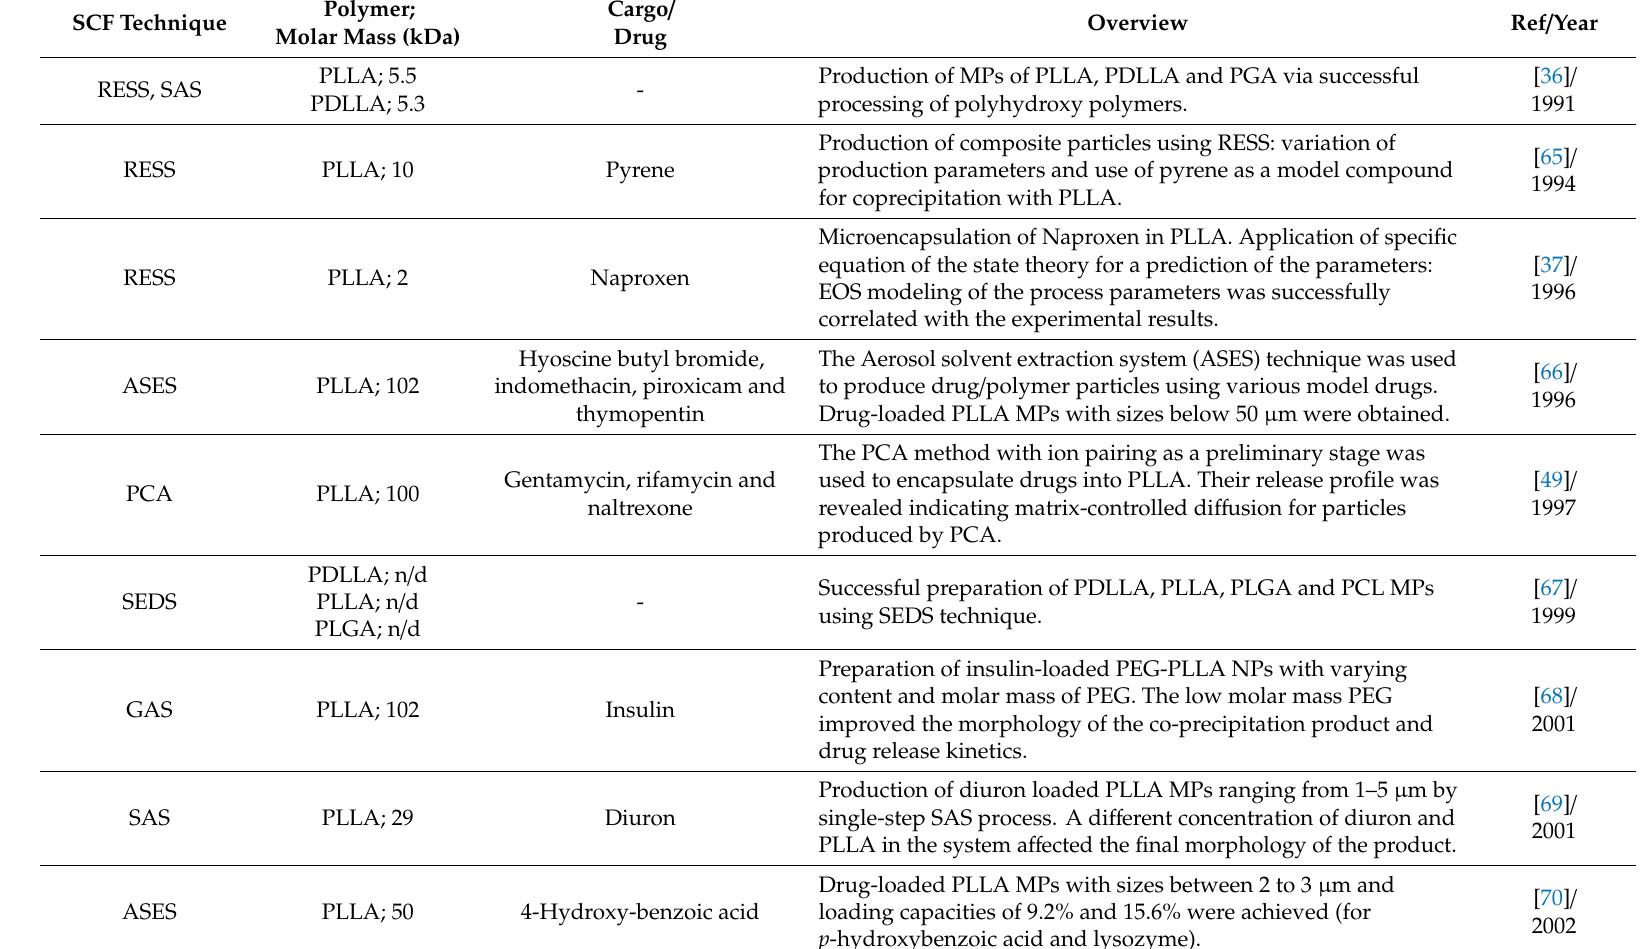
Table 2. Overview of (drug-loaded) PLA / PLGA particles obtained using SC-CO